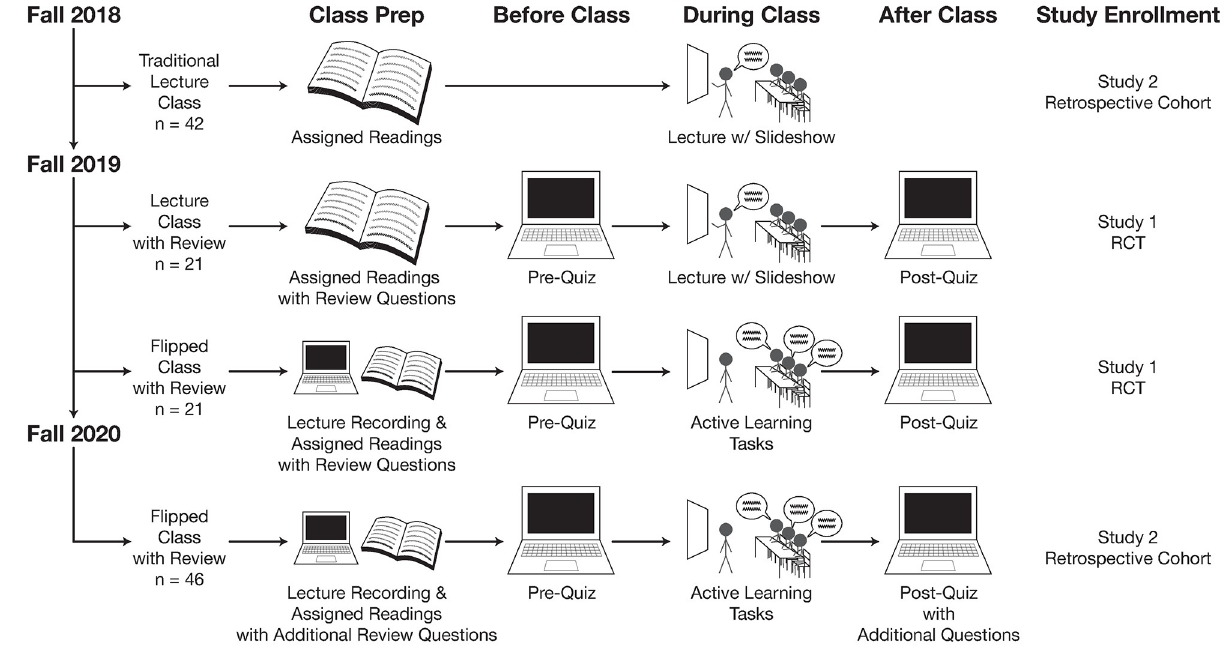
Fig 1. Development of the flipped class. In fall 2018, the course was structured as a lecture class. In fall 2019, the course was divided into two sections: a lecture class with review and a flipped class. Both class sections included the same review questions provided as: 1) open-ended review questions in the reading notes, 2) true-false questions in pre-quizzes, and 3) multiple-choice questions in post-quizzes. In fall 2020, the class was structured as a flipped class with additional review questions and new lecture